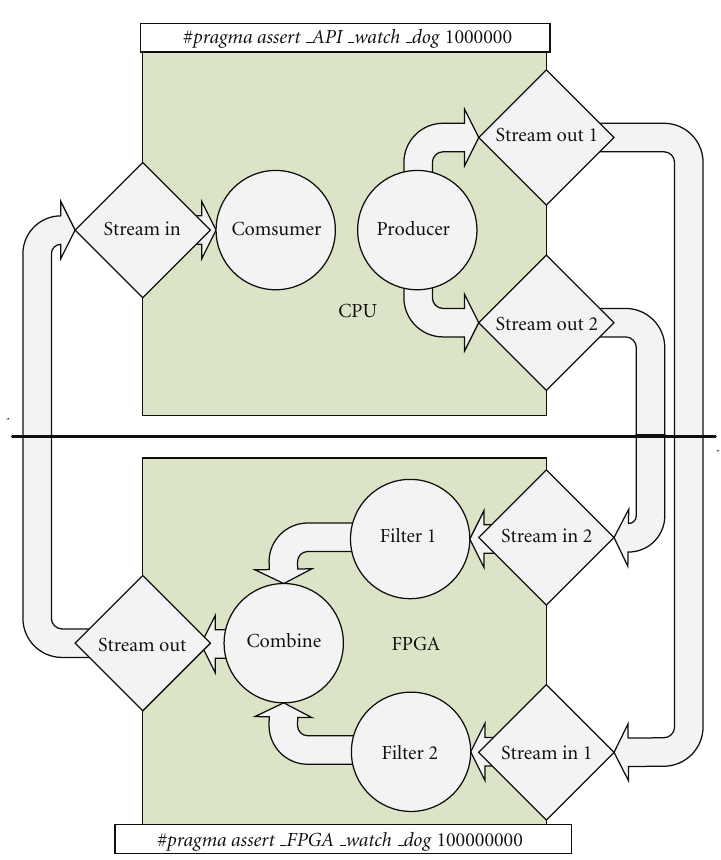
Figure 7: Using hang-detection assertions with a filter application.